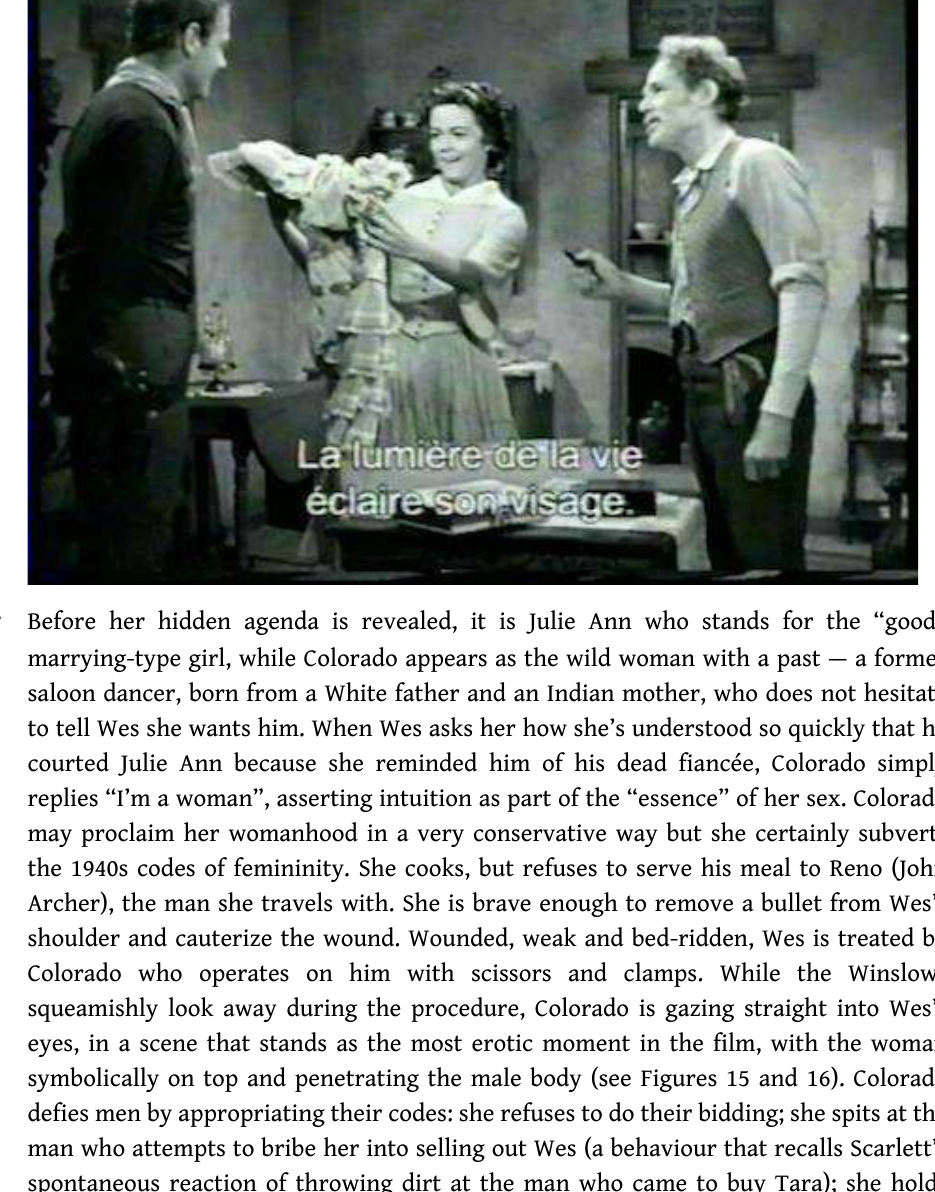
Figure 14: Wes bringing a fancy dress to Julie Ann in Colorado Territory